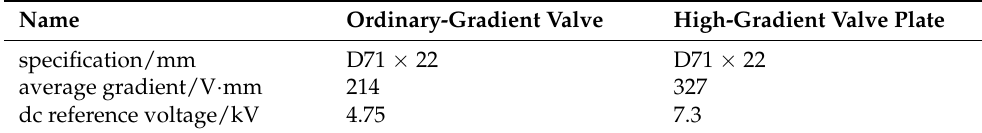
Table 2. Effectiveness of several gradient valve samples.